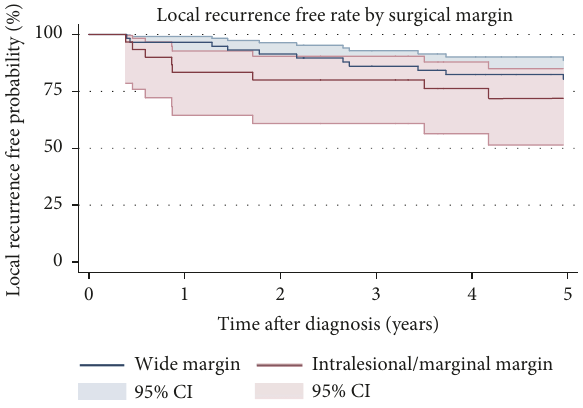
Figure 7: Kaplan-Meier estimates of local recurrence free rate by surgical margin. 95% confidence